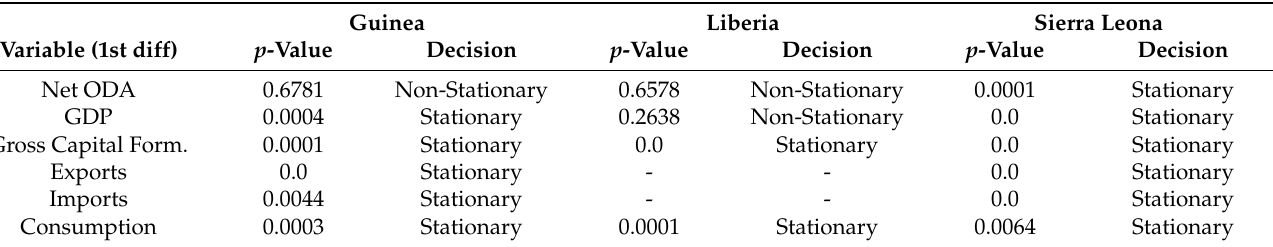
Table 3. Analysis of the stationarity of time series: step